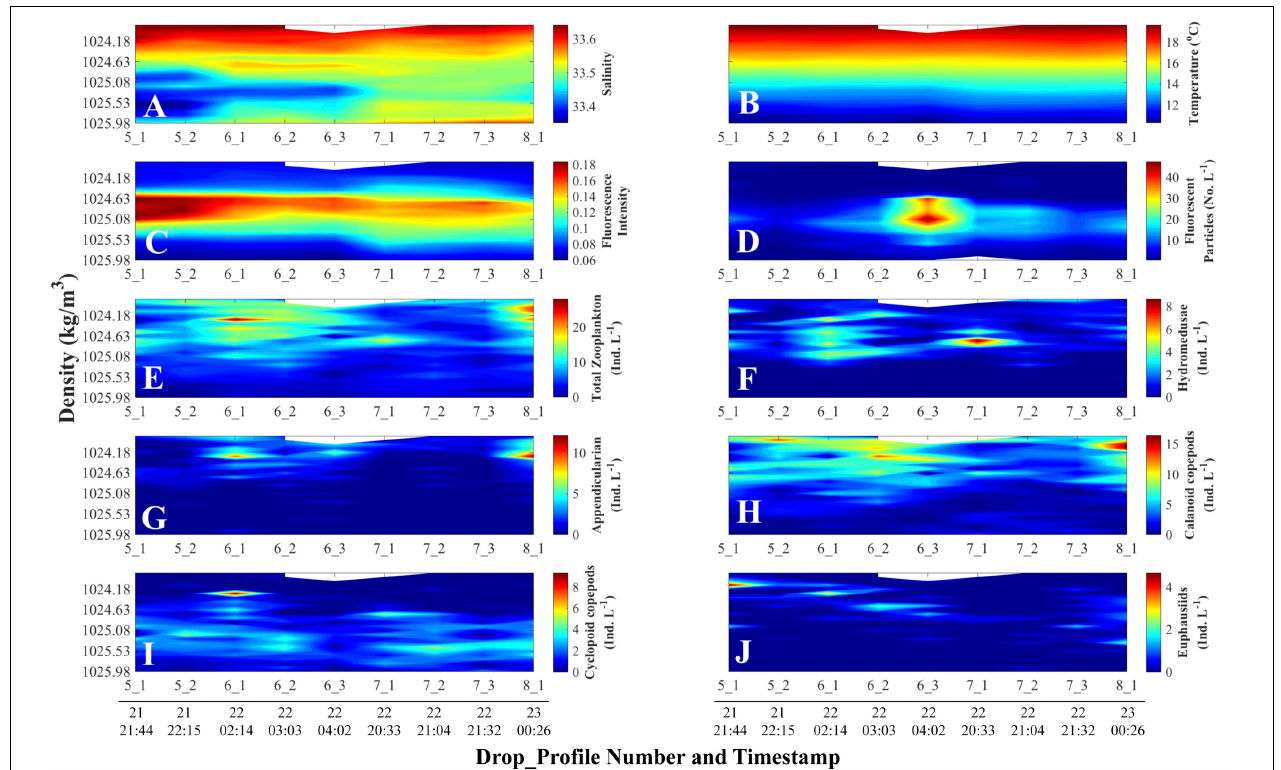
FIGURE 5 | Density-time distributions of physical and non-normalized biological data. Day and time (all in August 2011, Pacific Standard Time) are at the bottom of each column and apply to all the panels above the line of timestamps. Full details on each Drop_Profile can be found in Table 1 . (A) Salinity; (B) Temperature ( ◦ C); (C) Fluorescence Intensity (SBE 25 fluorometer); (D) Planar Laser Imaging Fluorometer (PLIF) fluorescent particle concentration (Numbers L − 1 ); Panels (E) through (J) represent O-Cam zooplankton concentrations (Individuals L − 1 ) data: (E) Total zooplankton concentration; (F) Hydromedusae; (G) Appendicularians; (H) Calanoid copepods; (I) Cyclopoid copepods; and (J)